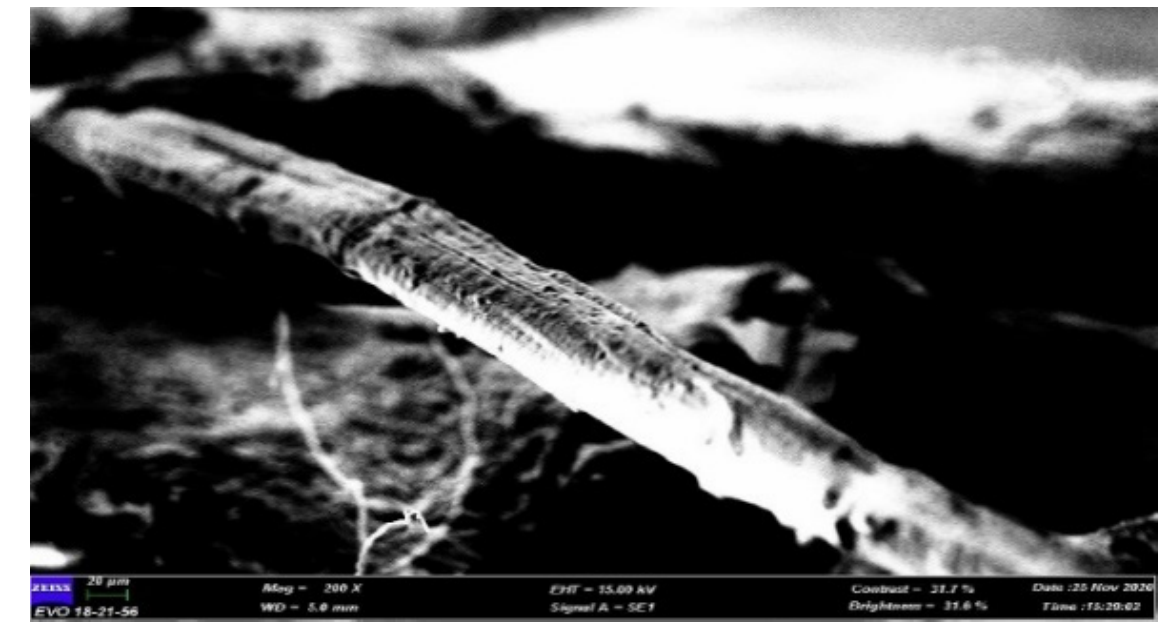
Figure 8. SEM micrograph of banana leaf fibre.